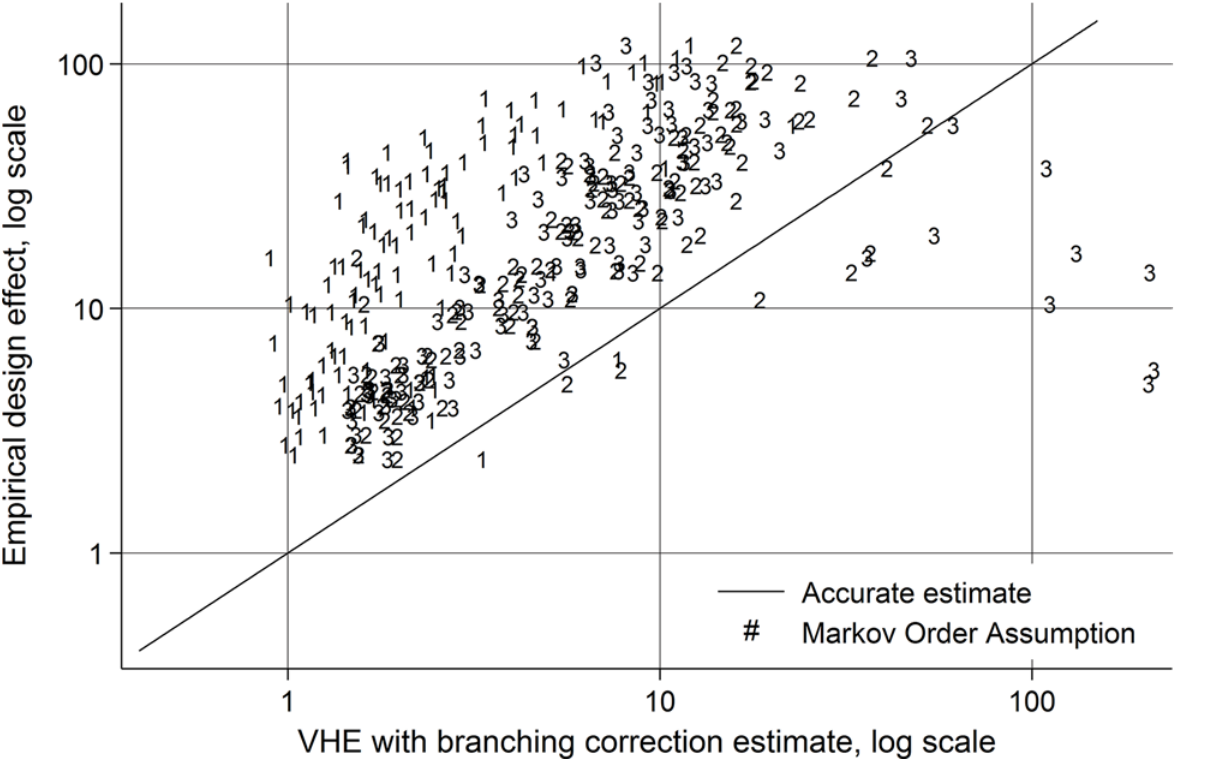
Fig 5. Population RDS sampling variance vs. VHE estimated sampling variance with branching correction under different Markov Order assumptions, for Race in the AH data set. Notes: Both scales are design effect scales and are logged. Symbols in the graph are as follows: 1 — FOM assumption (VHEwbc in Fig 4); 2 — Second Order Markov assumption (VHEhom in Fig 4); 3 — Third Order Markov Assumption (not shown in Fig